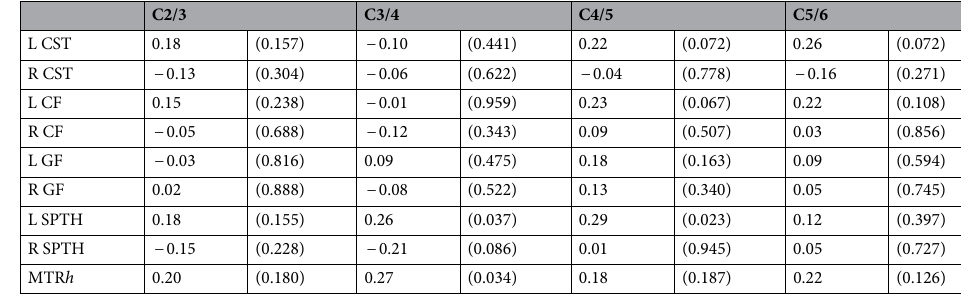
Table 8. Pearson correlations (with p value) between Neck Disability Index and imaging measures at each cervical level. White matter tracts above are the left and right corticospinal tracts (L and R CST), cuneate fasciculus (L and R CF), gracile fasciculus (L and R GF), and the combined spinothalamic and spinoreticular tracts (L and R